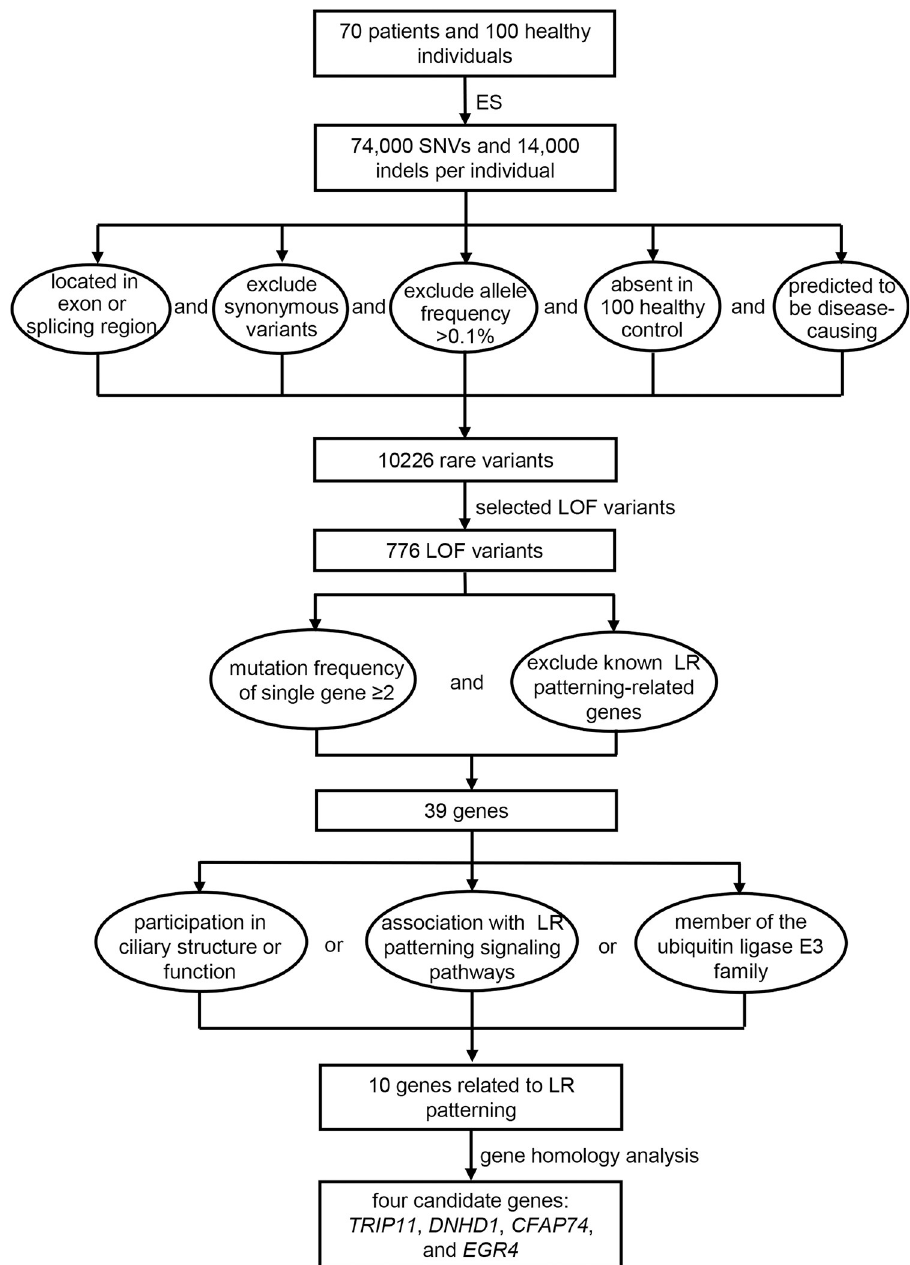
Fig 1. Schematic of the methodology applied to identify candidate genes. The results of ES performed on 70 patients were screened according to a series of criteria. 10226 rare variants were screened out. Among them, 776 LOF variants were selected for further analysis. 39 genes were identified from LOF variants for function and homology analysis. Finally, TRIP11 , DNHD1 , CFAP74 , and EGR4 were selected as candidate genes for further study.